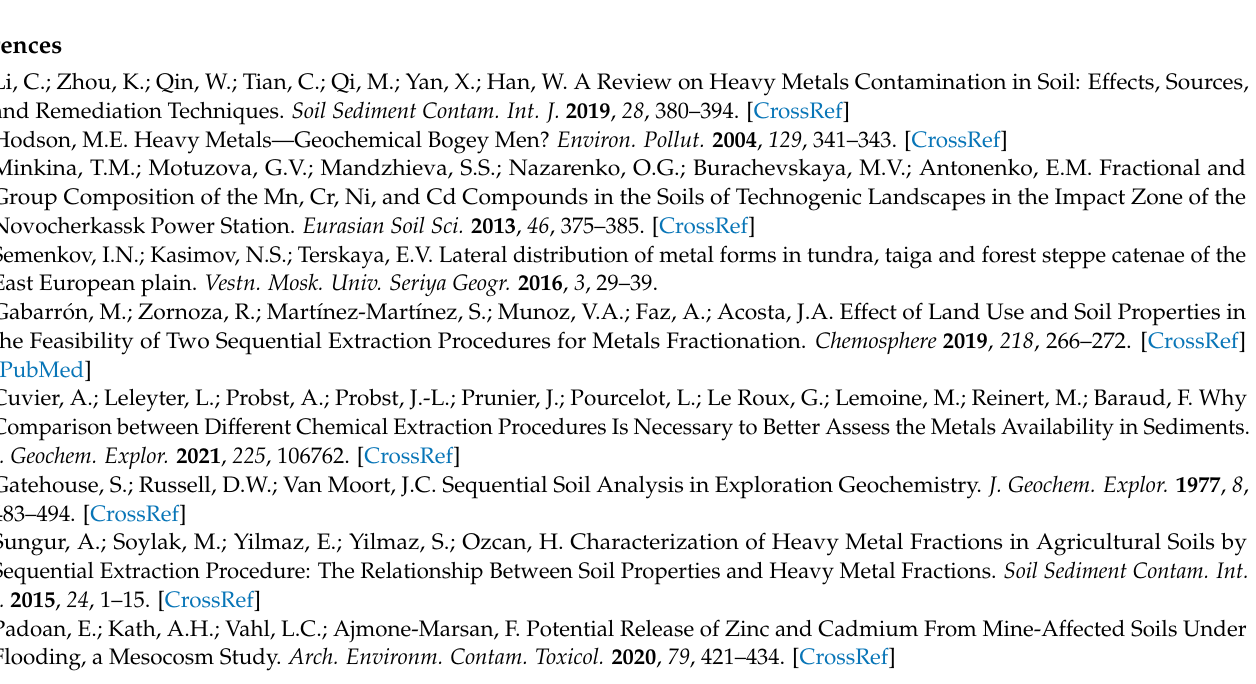
fractions. Table S2: Spearman’s rank correlation coefficients ( r s ) between the CAF and %F values. Figure S1: Dendrograms of %F and CAF for HMs in soils (a,b), bottom sediments (c,d), atmospheric PM 10 (e,f), and grain size fractions of road dust (g,h)—results of cluster analysis (amalgamation rule: complete linkage, distance measure: Euclidian